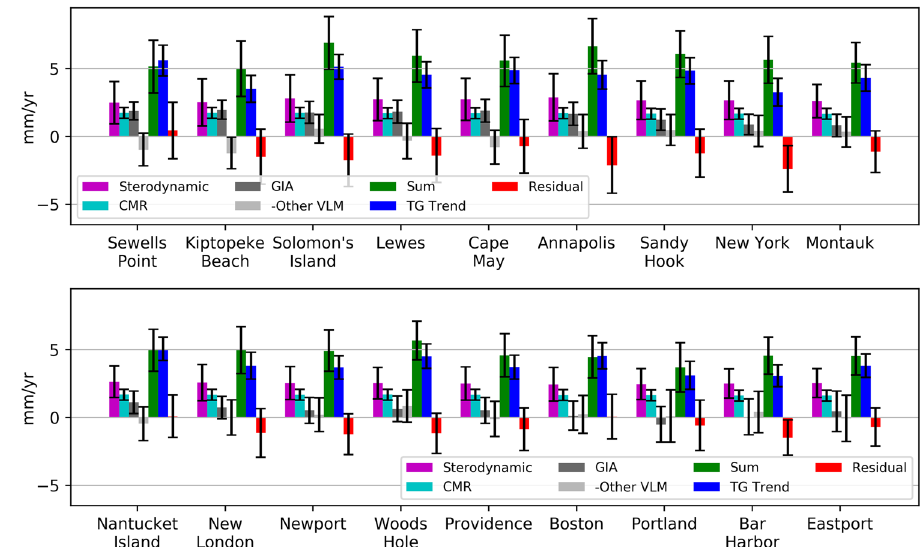
Fig. 4 Northeast sea level trends. Trend assessment from 1993 to 2018 for tide gauges along the U.S. East coast North of Cape Hatteras. Residuals are computed by subtracting the tide-gauge trend from the sum of the contemporary mass redistribution, sterodynamic effects, GIA, and non-GIA vertical land motion components. The vertical land motion component is inverted for interpretability. Uncertainty estimates represent two-standard deviations.